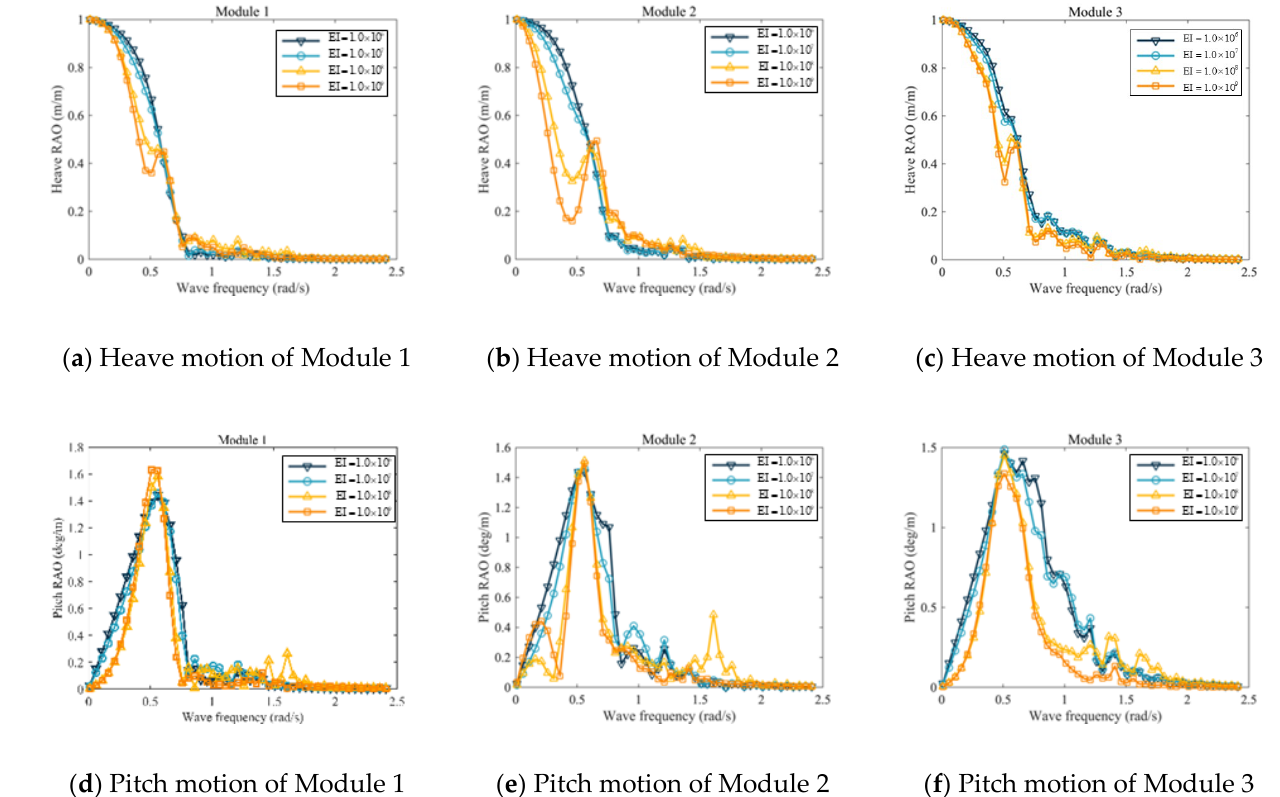
Figure 8. Heave and pitch motions of modules under different connection parameters